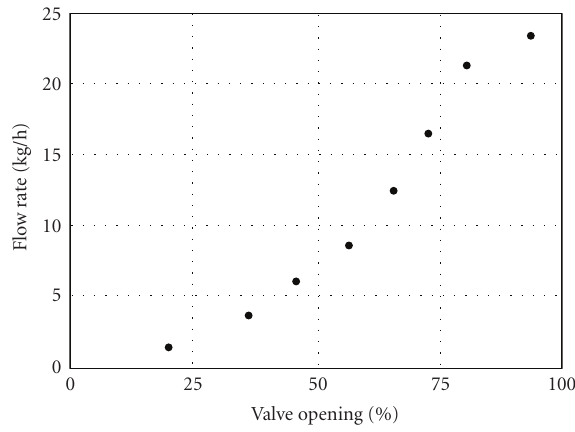
Figure 5: Control valve characteristics.